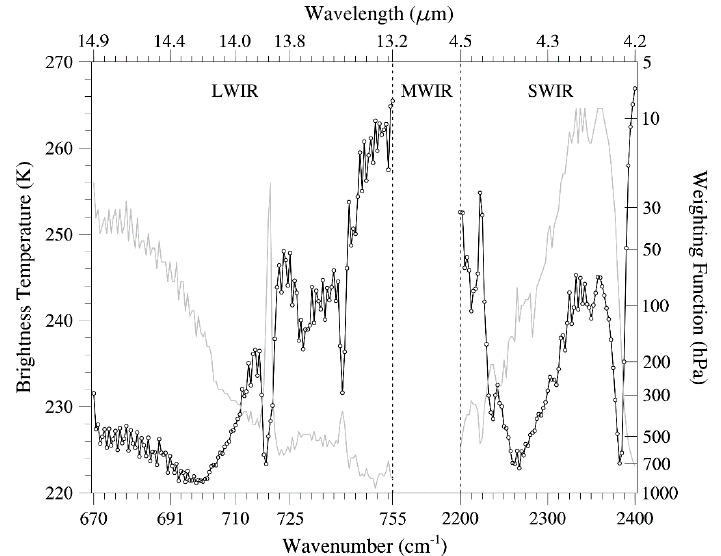
Figure 1. Radiative Transfer for TOVS (RTTOV) simulated brightness temperatures (black curves with open circle) and WF peaks (gray curves) for HIRAS LWIR and SWIR channels at CO 2 bands using the U.S. standard profile.